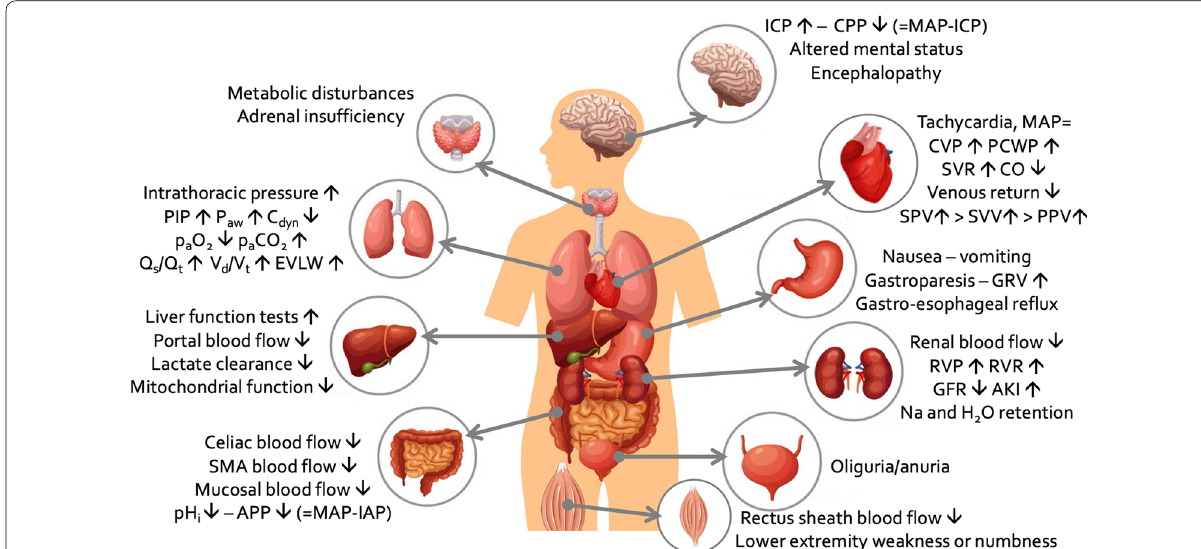
Fig. 1 Summary of the most important pathophysiologic effects of increased intra-abdominal pressure on end-organ function within and outside the abdominal cavity. AKI acute kidney injury, APP abdominal perfusion pressure, Cdyn dynamic respiratory compliance, CO cardiac output, CPP cerebral perfusion pressure, CVP central venous pressure, EVLW extravascular lung water, GFR glomerular filtration rate, GRV gastric residual volume,